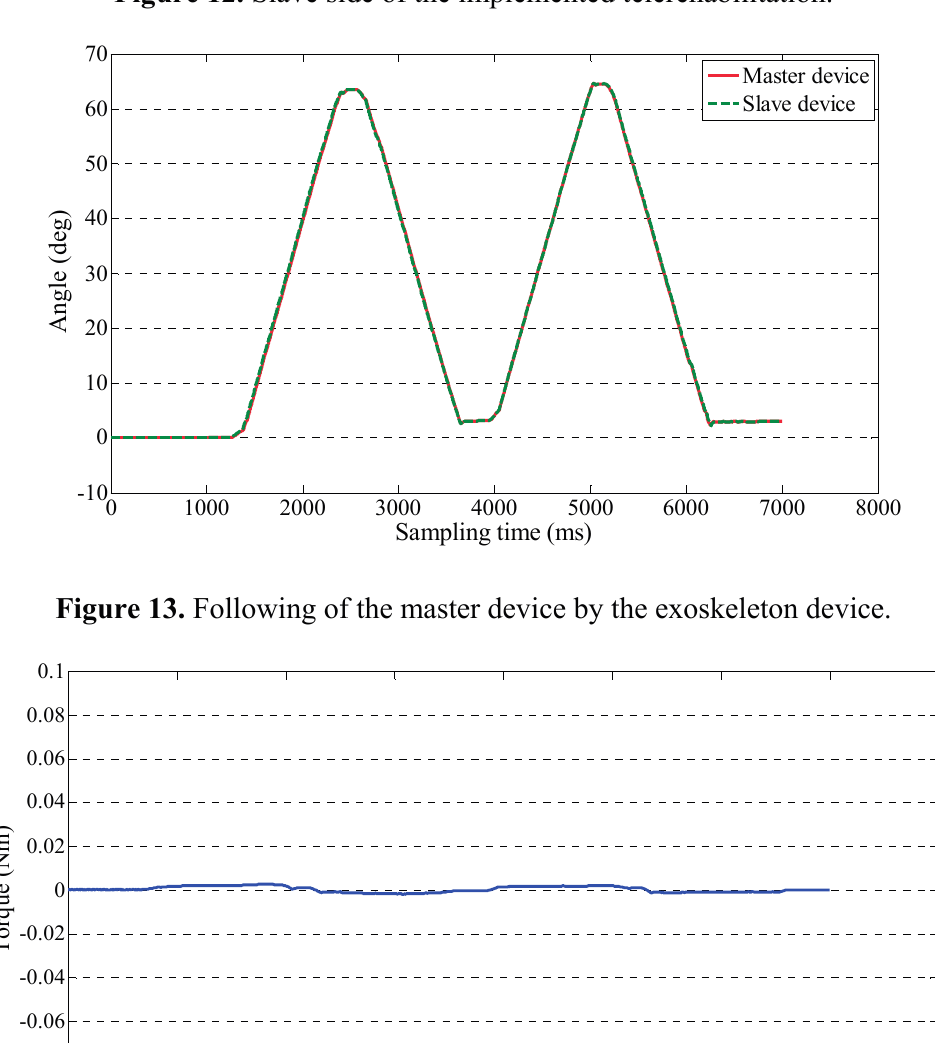
Figure 12. Slave side of the implemented telerehabilitation.